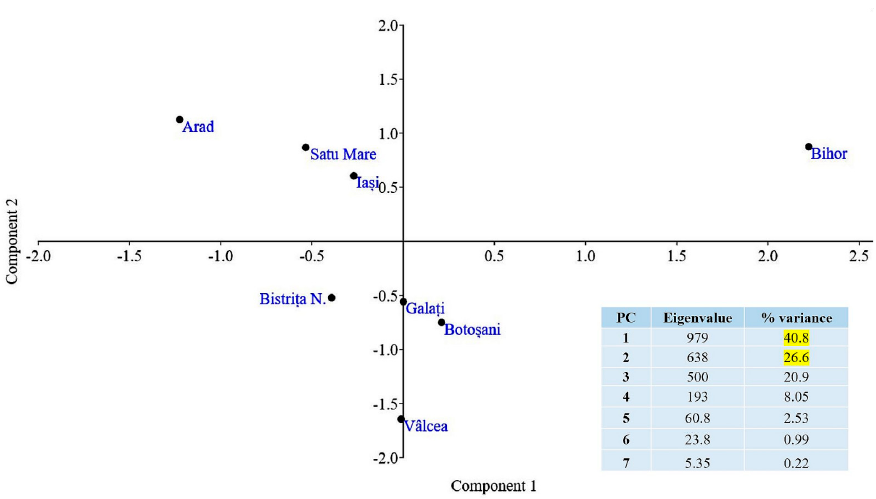
Figure 5. The hierarchical dendrogram of cluster analysis–paired group UPGMA (Unweighted Pair Group Method with Arithmetic Mean)–similarity index (Euclidean), based on the analysed parameters of the R. pseudoacacia provenances.